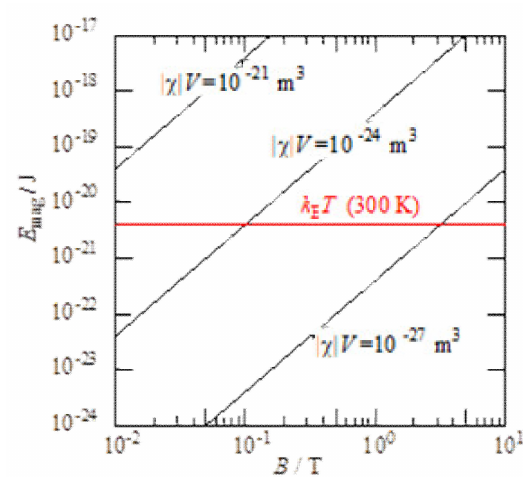
Figure 1. Magnetic energy E mag as a function of magnetic field B . Thermal energy k B T at 300 K is shown in the